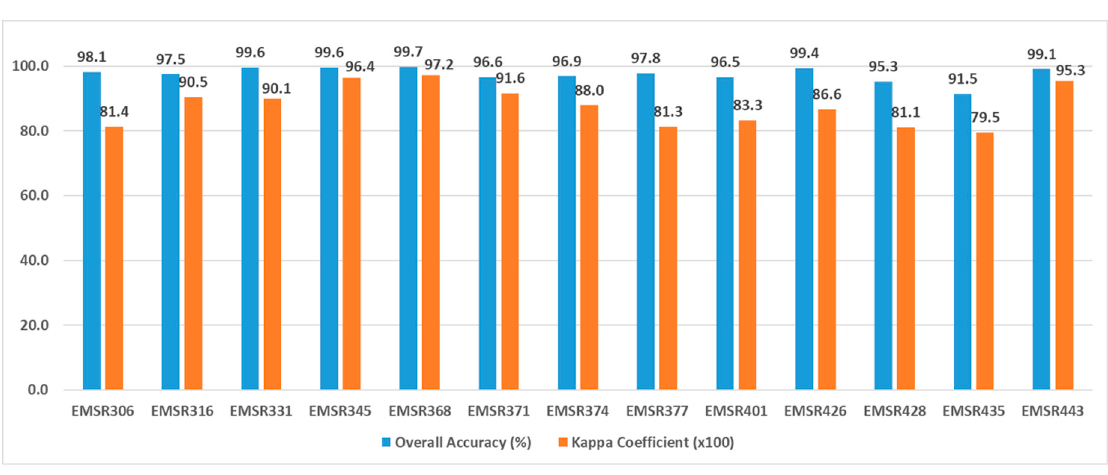
Figure 7. Agreement between CEMS-derived and BFCA-derived BA maps represented in terms of overall accuracy and kappa coefficient (multiplied by 100).